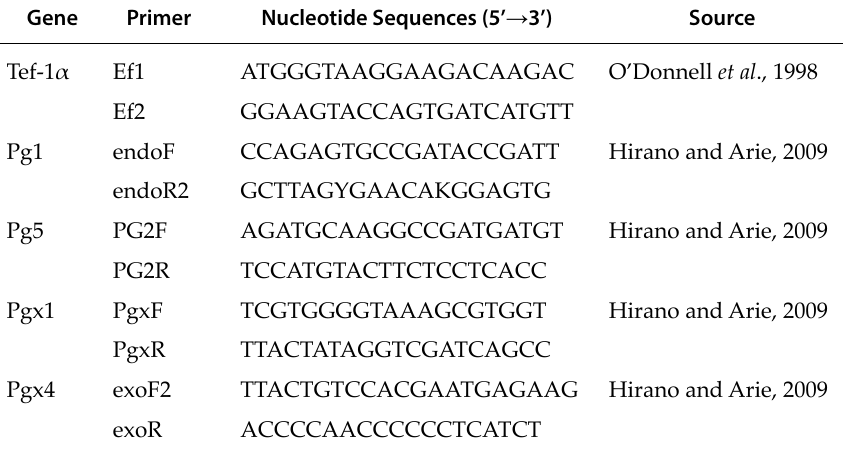
Table 2. Primers used to amplify EF-1α and polygalacturonase